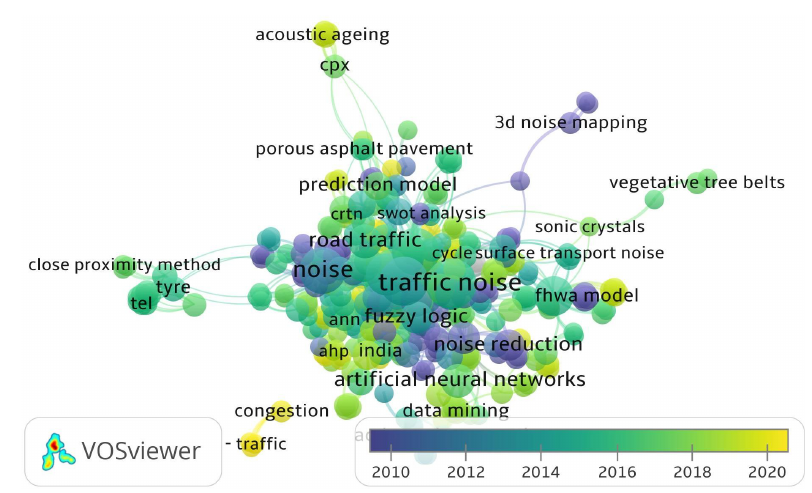
Figure 2: Overlay analysis of examined papers showing the publication